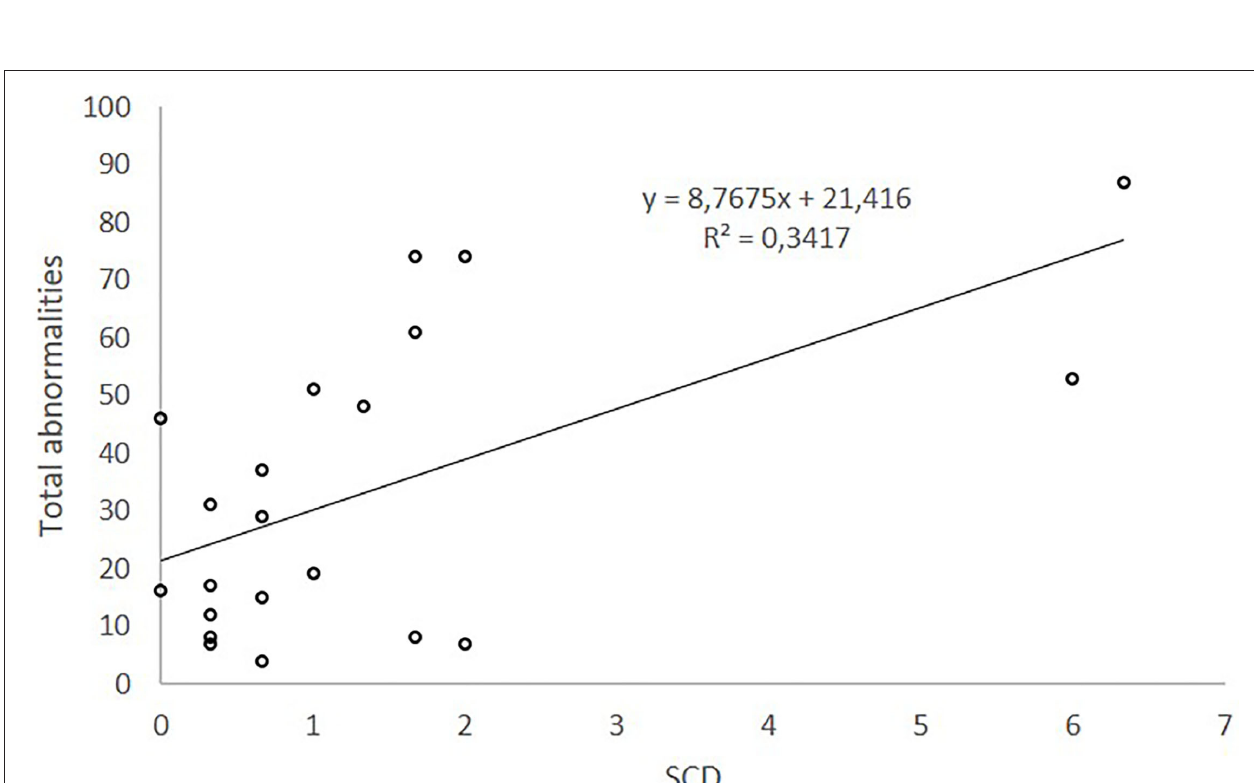
FIGURE 2 | Relationship between sDF index measured by SCSA and TUNEL.